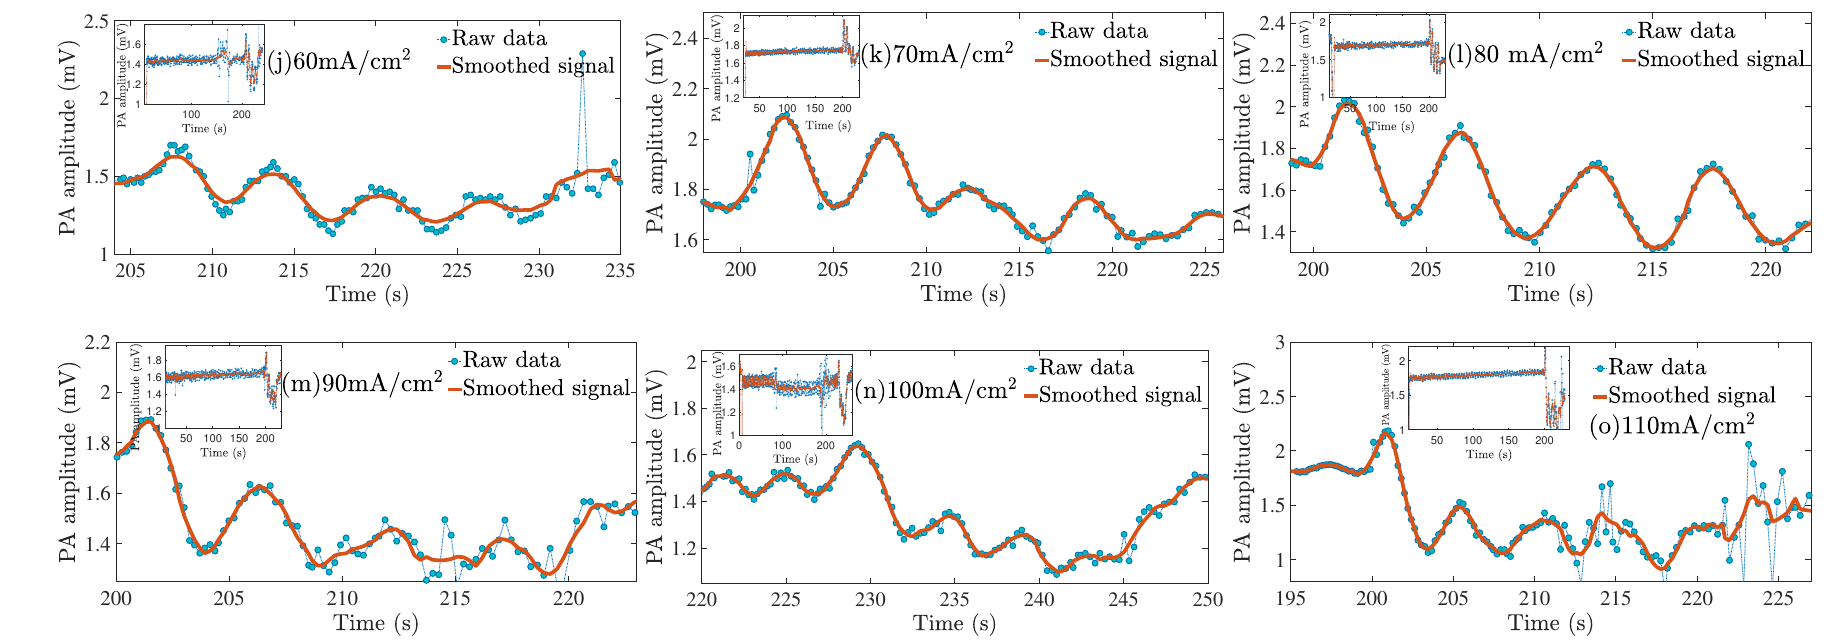
Figure A1. Show the in situ photoacoustic amplitude recorded during the etching process. Each graph corresponds to a specific current density for the samples summarized in Table 1. The PA amplitude changes periodically at the moment of the current injection due to thin-film interference between PSi and Si substrate. The insets show the complete anodizing